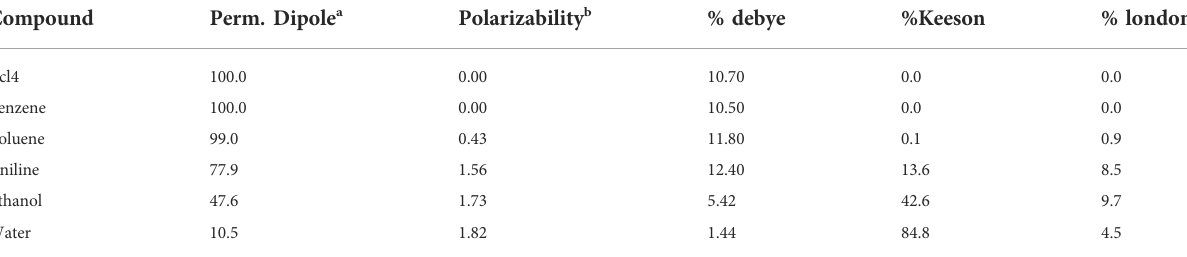
Data from Table 10.2 of reference 17. a D